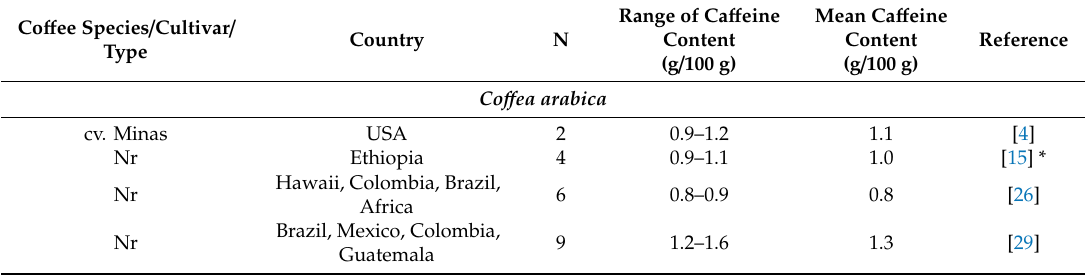
Table 1. Summary data from studies investigating the ca ff eine contents in roasted Co ff ea arabica , and Co ff ea canephora seeds, commercial blends and soluble co ff ees. Co ff ee Species / Cultivar